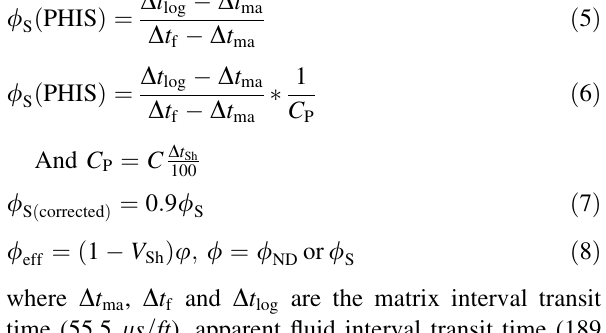
where q , q and q are the grain density (2.65 g/cc), g f b apparent fluid density (1.01 g/cc) and the bulk density from the density log, respectively.